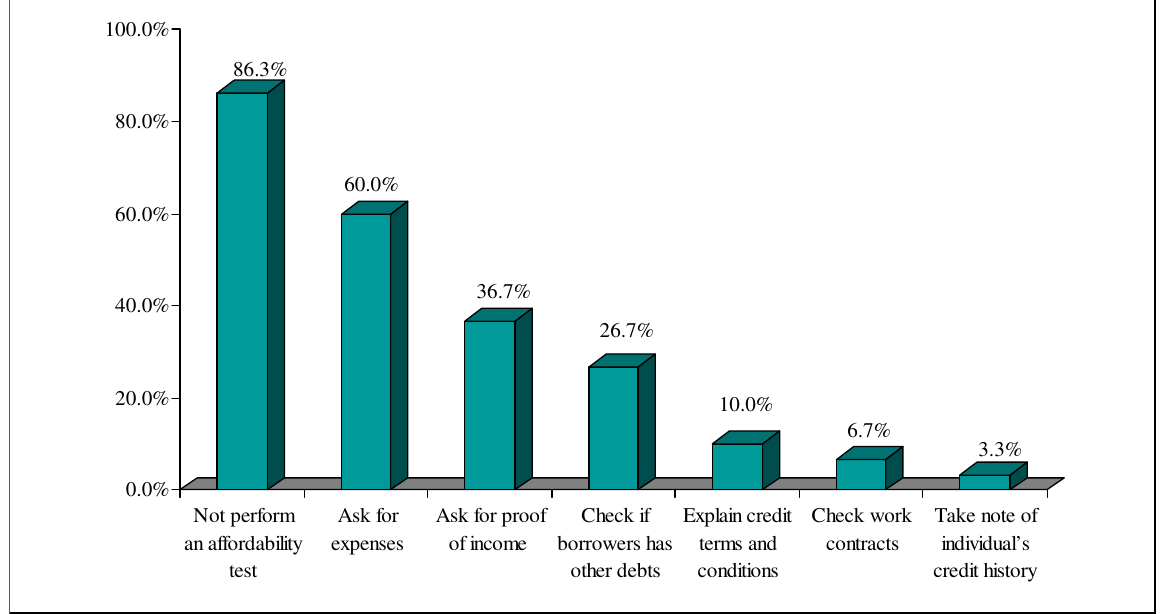
Fig. 4. Specific reckless lending